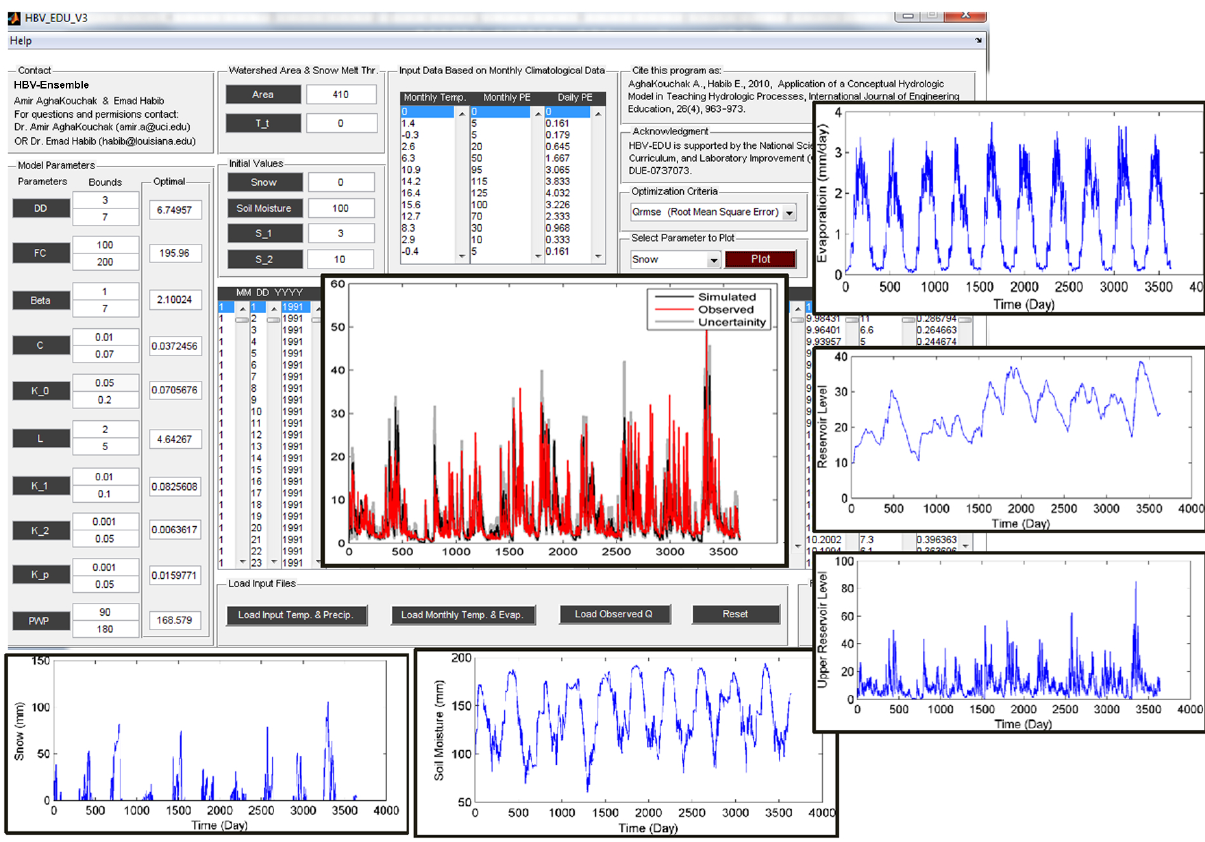
Fig. 3. HBV-ensemble sample model outputs (snow accumulation, soil moisture, evapotranspiration, and upper and lower reservoir water levels).